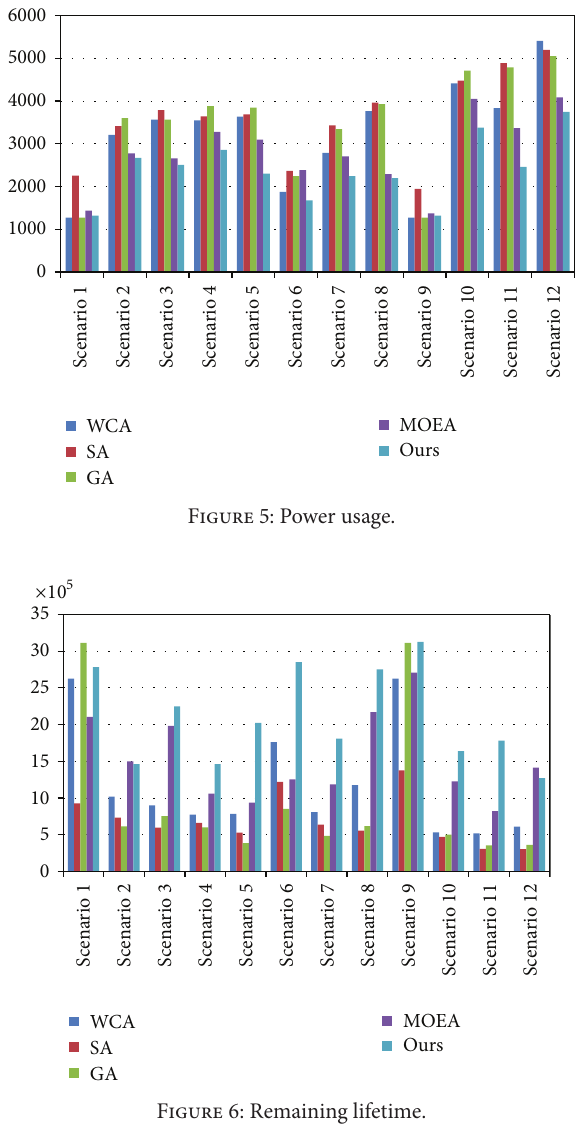
Figure 6: Remaining